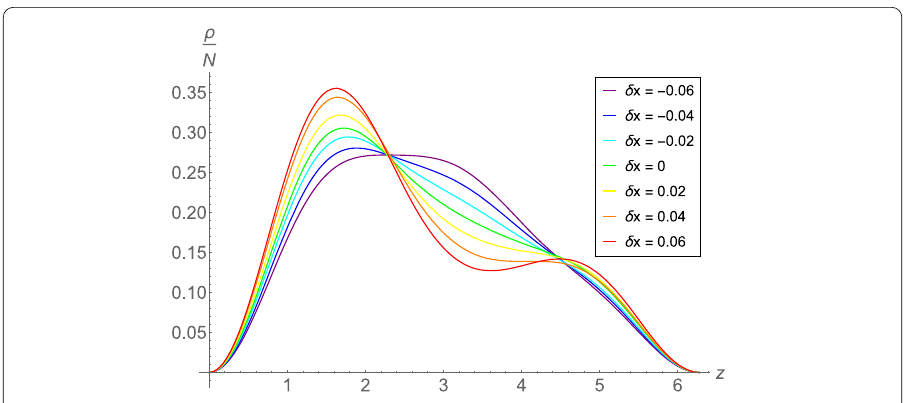
Figure 9 Variations of the critical state at λ = 2.083 for N = 60 in position space. The relative particle density ρ / N is plotted. The green line corresponds to the critical state | Φ inf (cid:2) itself and the adjacent lines are variations of it, which we obtained by slightly changing the value of x used in the minimization procedure that determines the quantum state: x i = x inf ( λ ) + δ x i . The values of δ x i are indicated in the